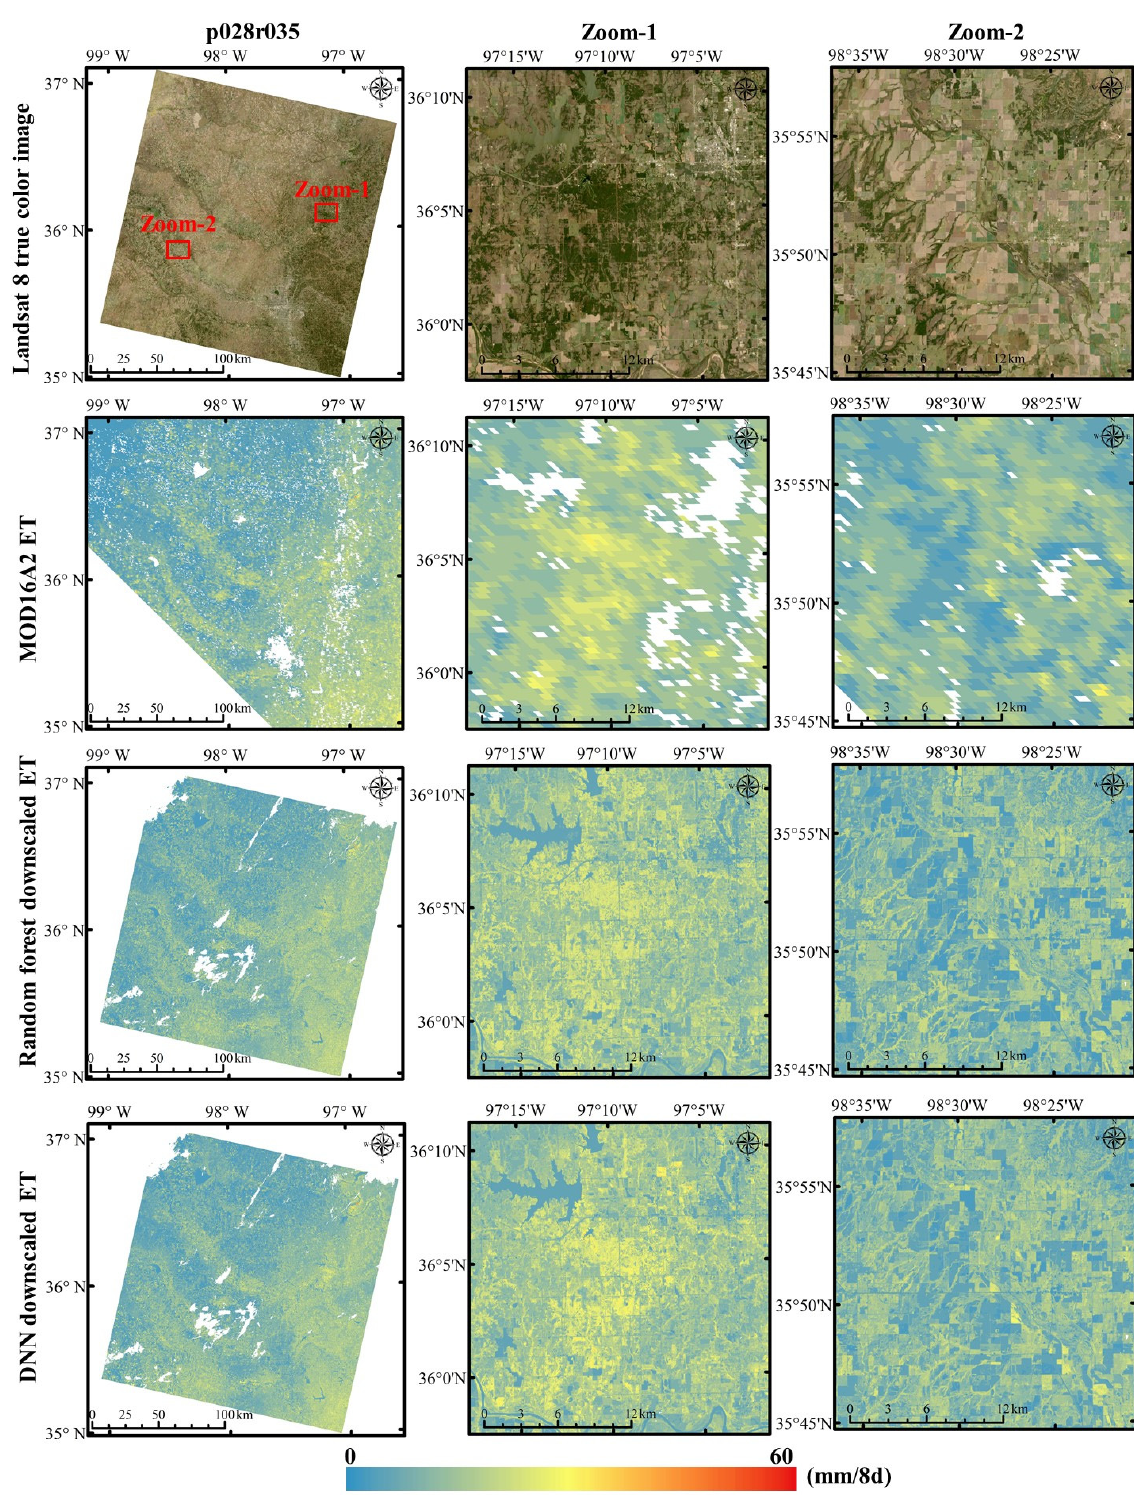
Figure 5. Same as Figure 4 but for the p028r035 region with Landsat 8 image acquired on 17 October 2016.